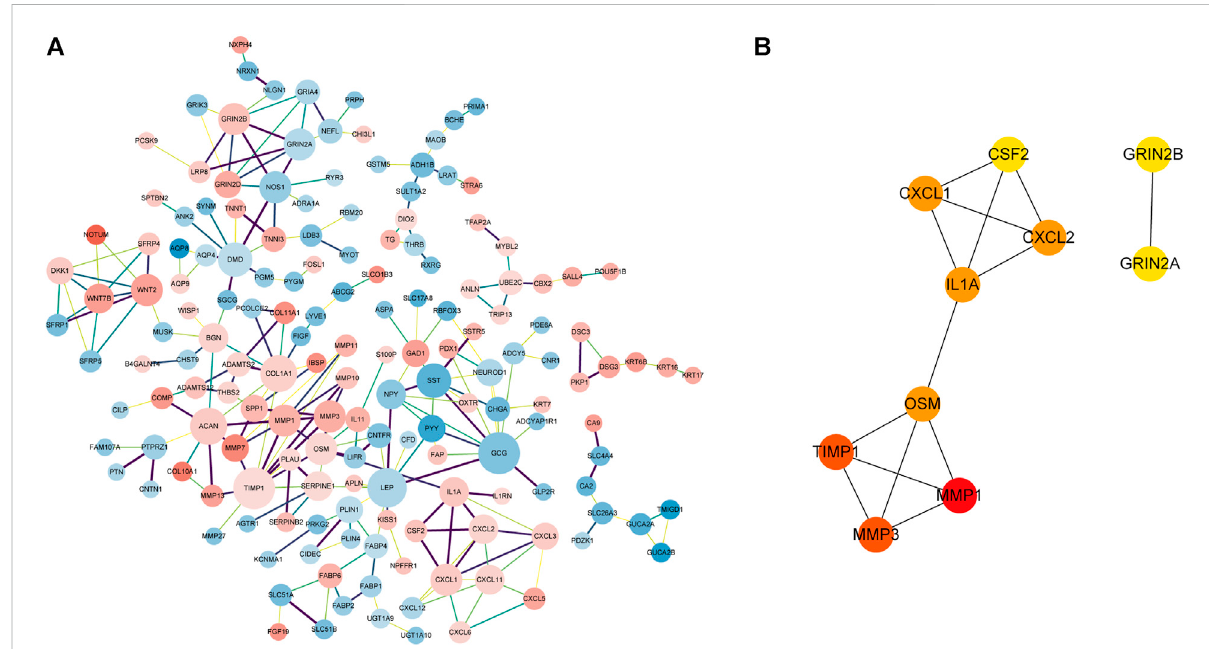
FIGURE 5 PPI network of DEGs and hub genes in the network. (A) . PPI network of DEGs with the interaction score > 0.7. The pink nodes indicate signi fi cantly upregulated genes and the blue nodes indicate signi fi cantly downregulated genes. The edge thickness is proportional to the combined scoreoftheconnectedgenes.Thesizeofthenodeisproportionaltothevalueoflog2|FC|. (B)